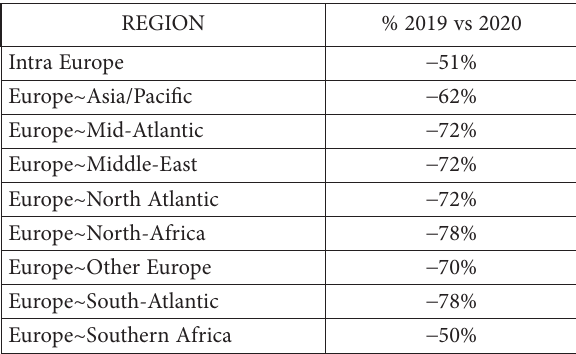
Table 2. Situation of flights with Europe in 2020 vs